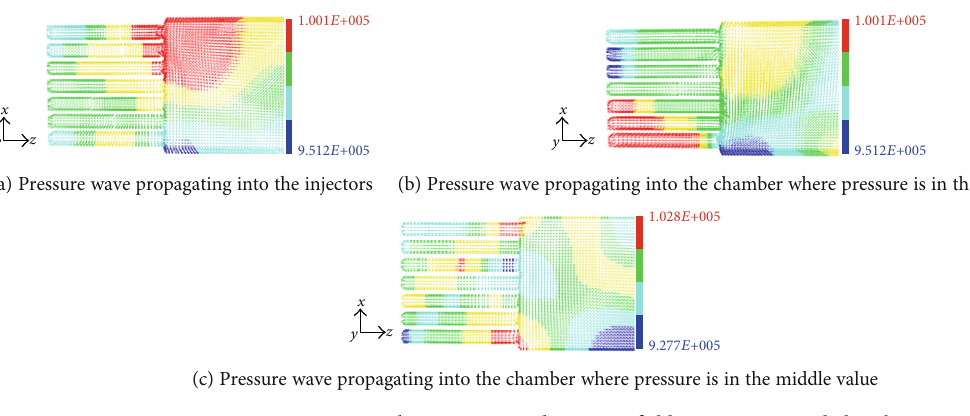
Figure 8: Instantaneous velocity vector and pressure fi elds in injectors and chamber.